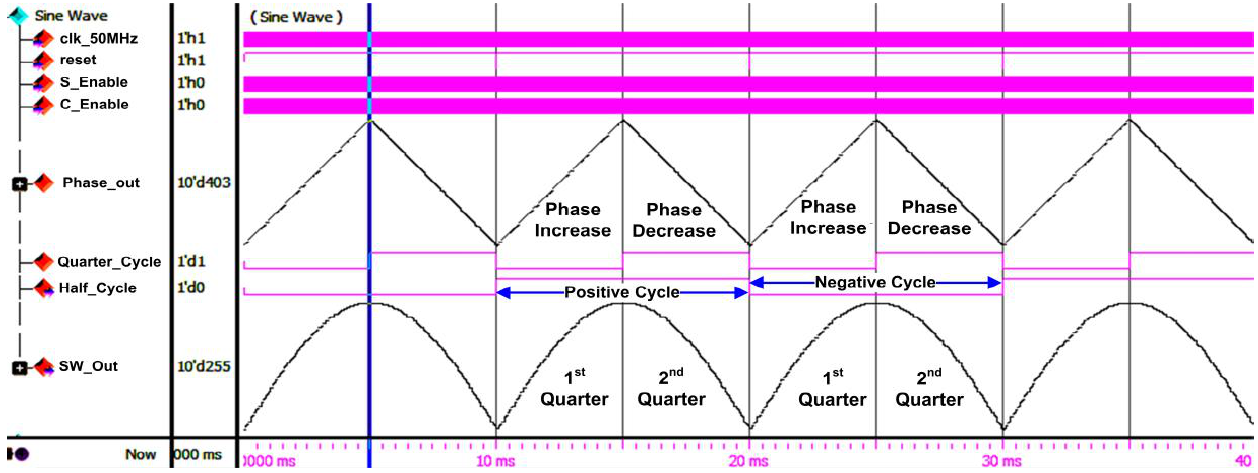
Figure 18. RTL simulation results for the reference sine-wave generation of the SPWM digital switching controller.